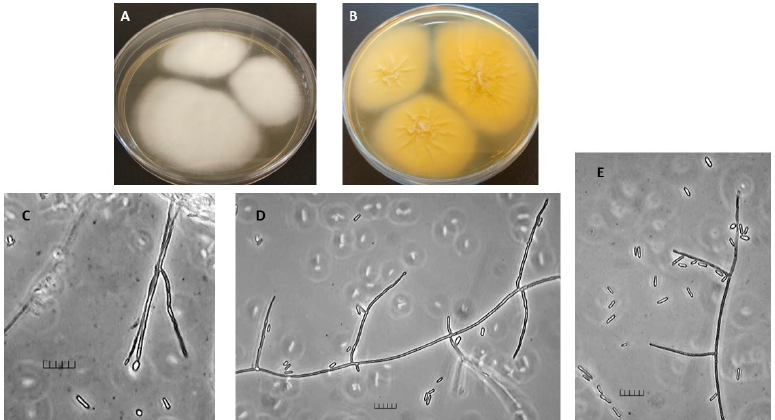
Figure 1. Akanthomyces uredinophilus . Upper ( A ) and reverse ( B ) view of cultures on SDAY after 12 days incubation. Verticillate phialides ( C ), phialides produced from prostrate hypha ( D ), phialides and conidia ( E ). Scale bar: 10 µm.